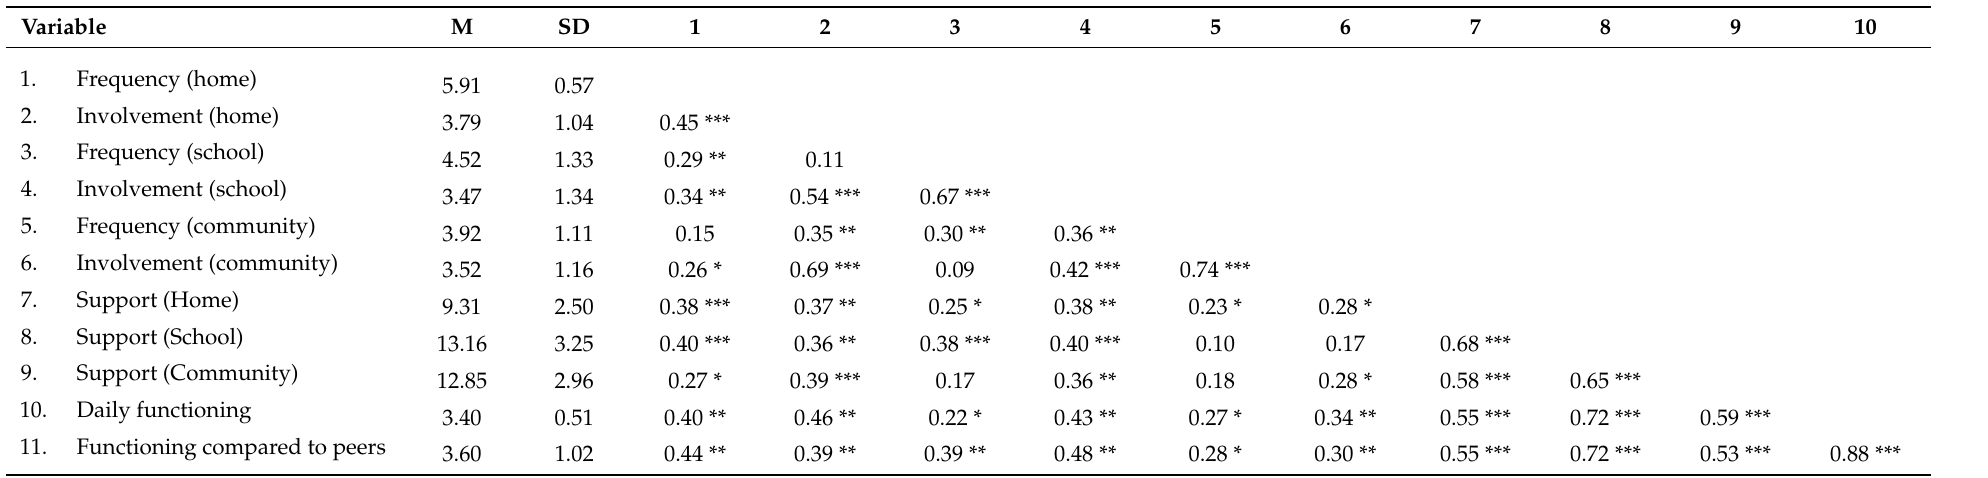
Table 1. Means, standard deviations and correlations among study